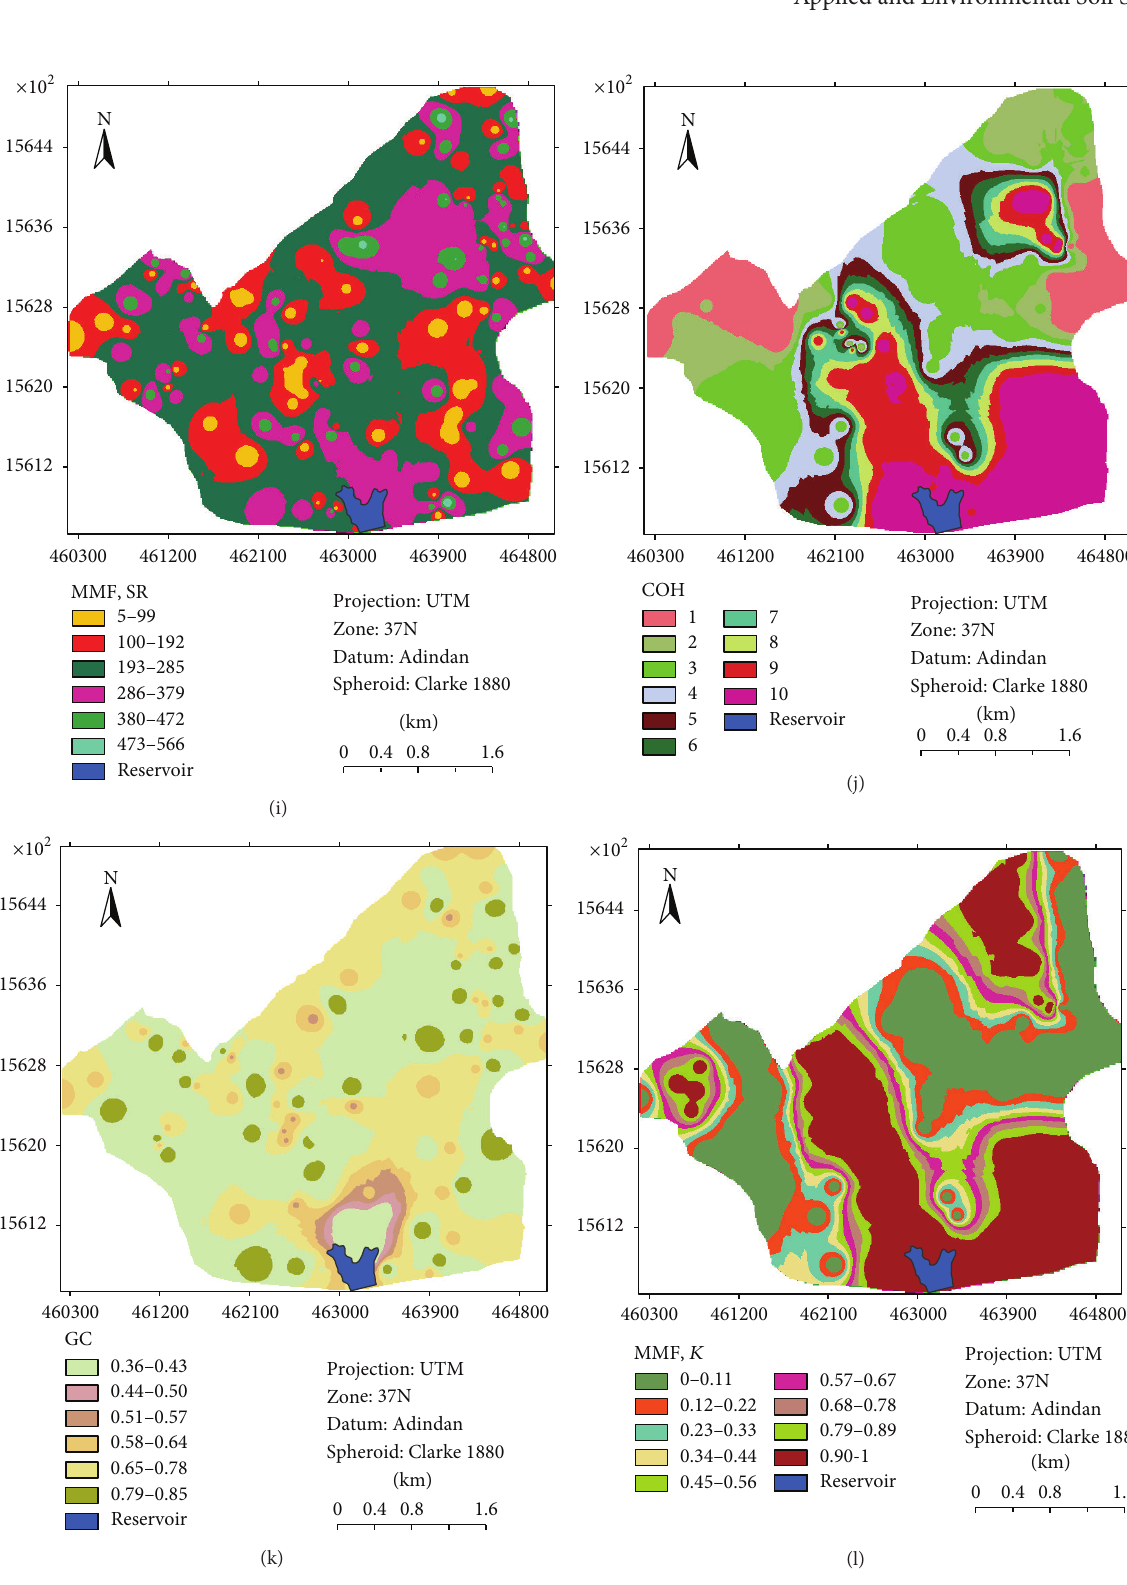
Figure 5: Spatial distribution of parameters influencing the hydrology/erosion of the catchment: (a) slope; (b) soil texture; (c) bulk density (Mgm −3 ); (d) moisture at field capacity (%); (e) EHD, effective hydrological top soil depth (cm); (f) 𝐸 𝑡 / 𝐸 𝑜 , actual to potential evaporation; (g) cover management factor; (h) SMSC, soil moisture storage capacity (mm); (i) SR, surface runoff (Q) (mm); (j) COH, cohesion of the soil surface (KPa); (k) GC, fraction of ground cover (0-1); and (l) 𝐾 , soil detachability